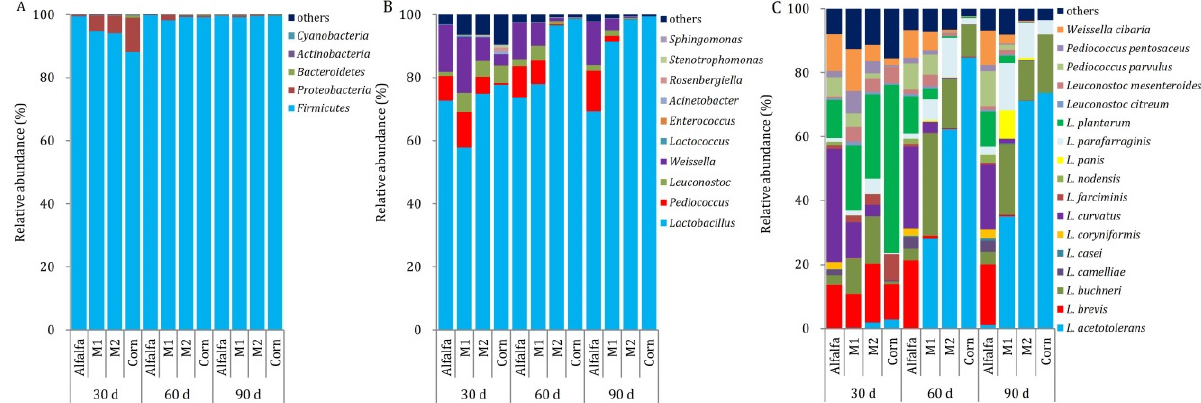
Figure 2. Dynamics of bacterial community of silage during storage at the phylum ( A ), genus ( B ) and species ( C ) levels ( n = 3). M1 and M2, alfalfa and corn mixed with ratio of 0.8:0.2 and 0.6:0.4 on a fresh weight basis.